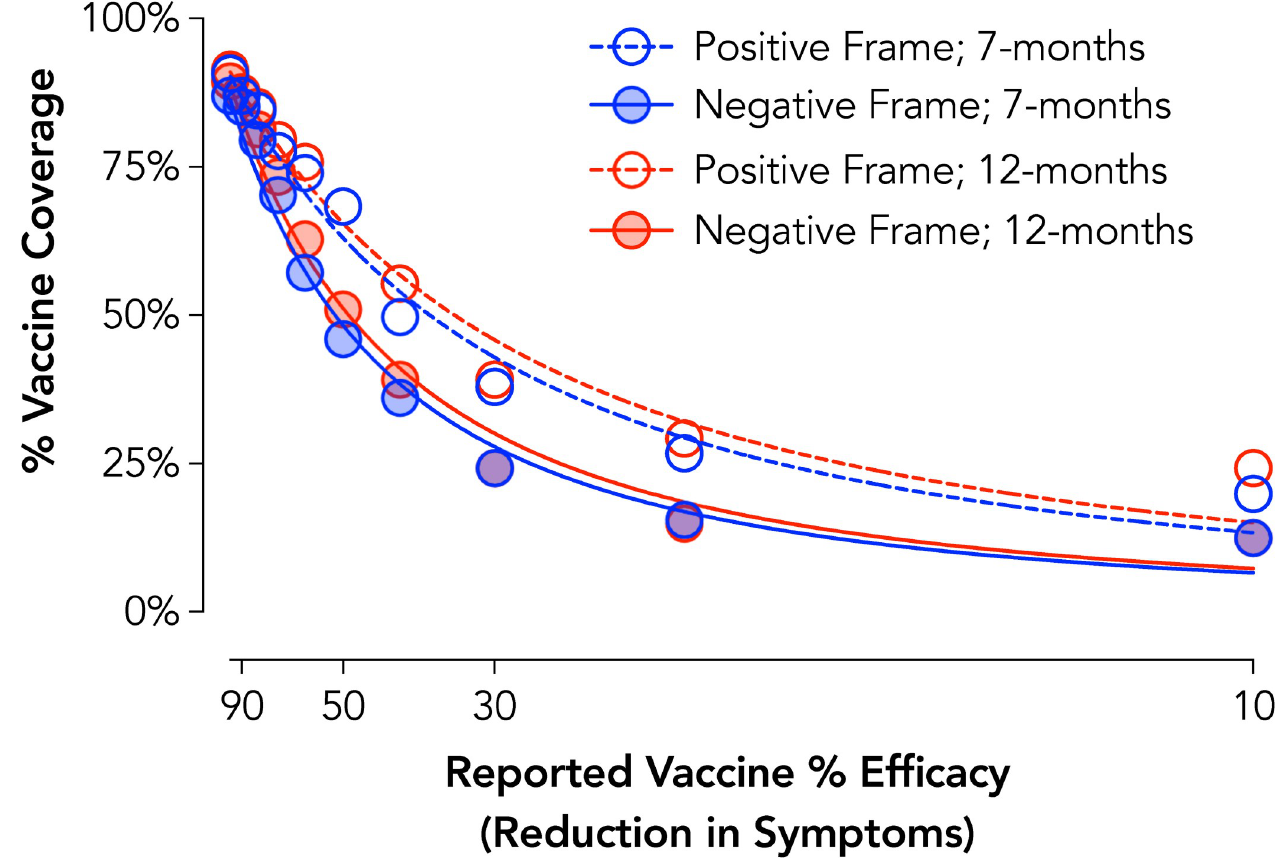
Fig 7. COVID-19 vaccine acceptance by development timeline and safety framing. Plotted are group discounting curves by developmental timeline (7-months = blue; 12-months = red) and safety framing (positive = open circles/dotted lines; negative = full circles/lines). X axis values are computed as odds against symptom reduction. Curves are plotted using the hyperbolic discounting equation including a non-linear scaling parameter [43].